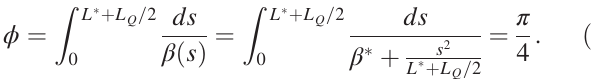
= 2 , the relative Q